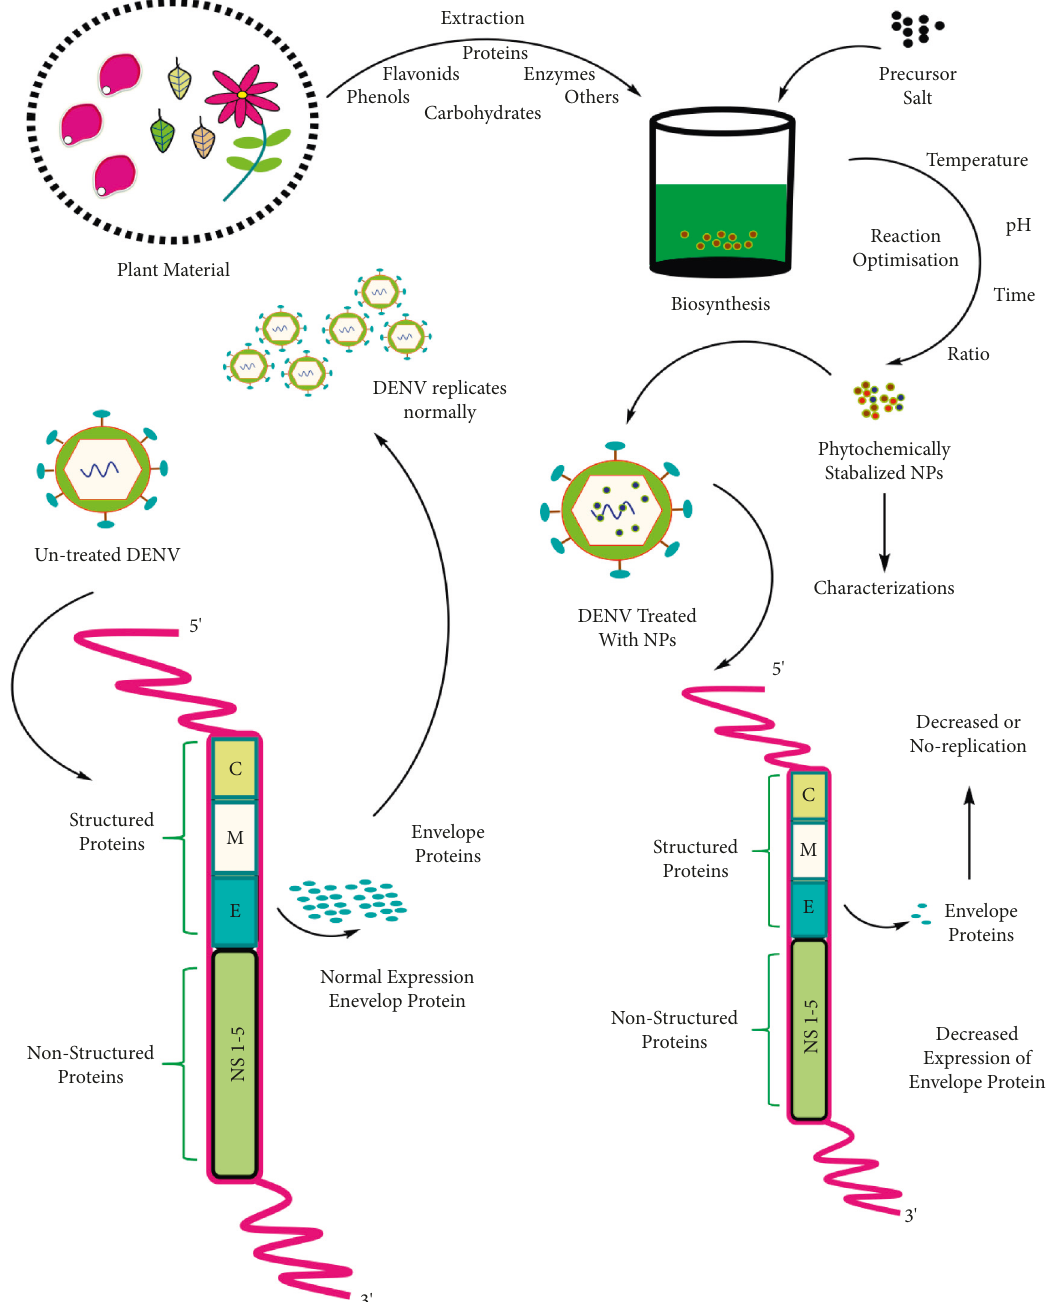
Figure 1: Molecular interaction of biogenic NPs with the DENV genome causing decreased expression of viral